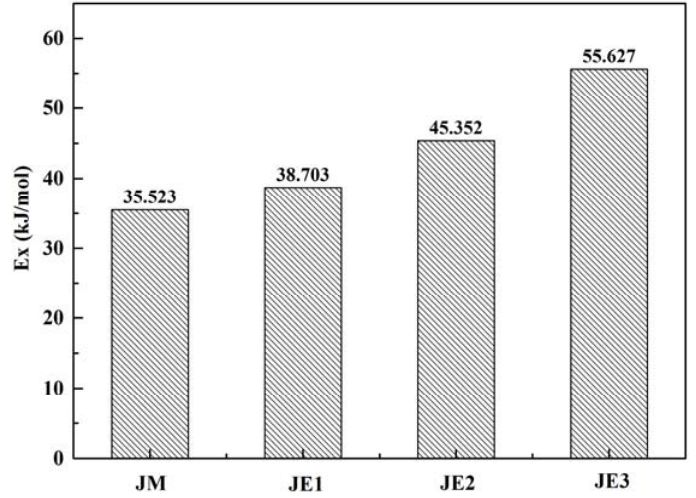
Figure 8. Weighted apparent activation energies of the briquette samples.